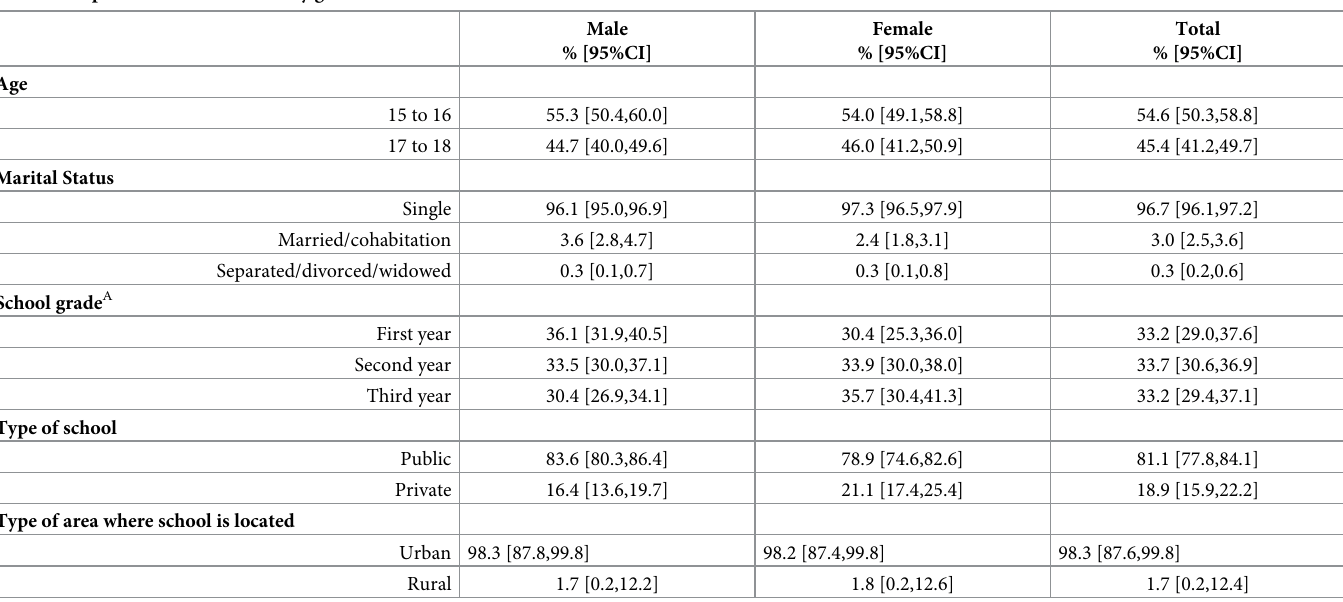
Table 3. Population characteristics by gender. Mexico